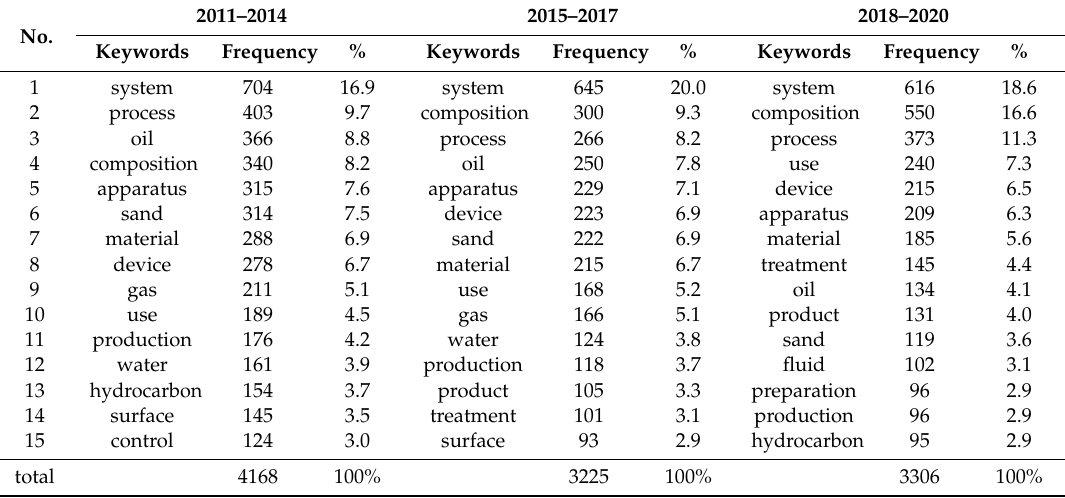
Table A1. Network analysis results of topic modeling analysis by time